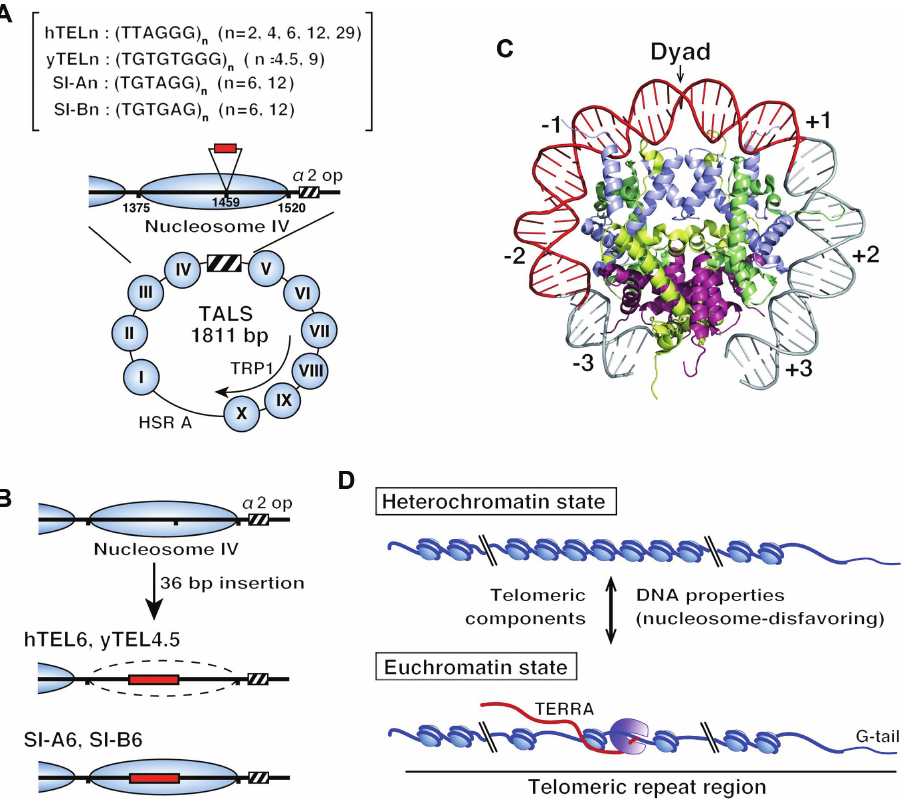
Figure 1 Telomeric repeats act as nucleosome-disfavoring sequences in vivo . (A) Experimental design. Several human and yeast telomeric repeat sequences were inserted into the positioned nucleosome IV in the yeast minichromosome TALS (figure modified from ref. 28). (B) Summary of the effects of the 36-bp telomeric repeats (hTEL6 and yTEL4.5), as well as the sequence-isomers of human telomeric repeats (SI-A6, SI-B6). (C) Projection of 36 bp of the human telomeric repeat sequence (hTEL6) on the crystal structure of the yeast nucleosome core particle (PDB: 11D3) (35) (figure modified from ref. 28). (D) A model for the dynamics of telomeric chromatin: inter-conversion between the euchromatic and heterochromatic states in the telomeric repeat region. The proper- ties of the DNA in telomeric repeat sequences cause the formation of labile nucleosomes, thus facilitating the inter-conversion. Telomeric components are also responsible for the dynamic alterations of chromatin states. In the euchromatic state, telomeric repeat sequences are transcribed into TERRA (shown in